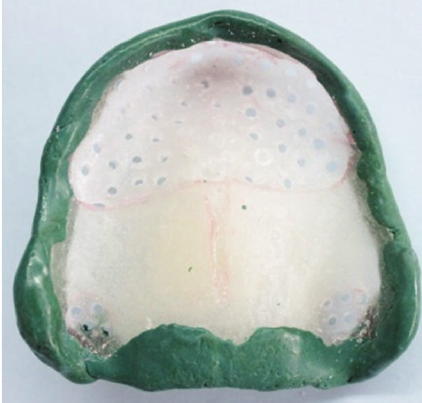
Figure 14: Maxillary custom tray with multiple relief holes.